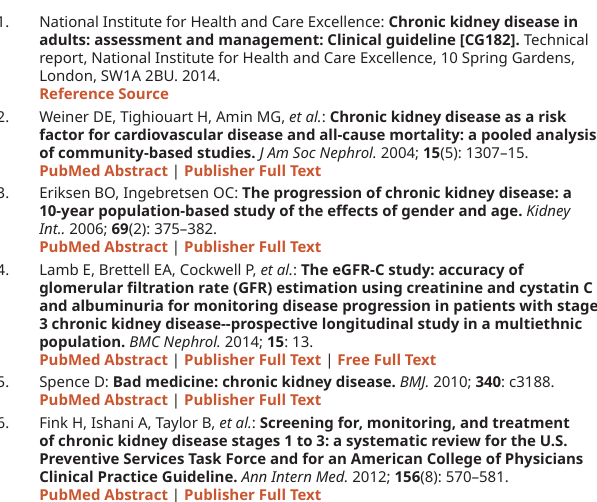
Extended data Figshare: Statistical models for the deterioration of kidney function in a primary care population: A